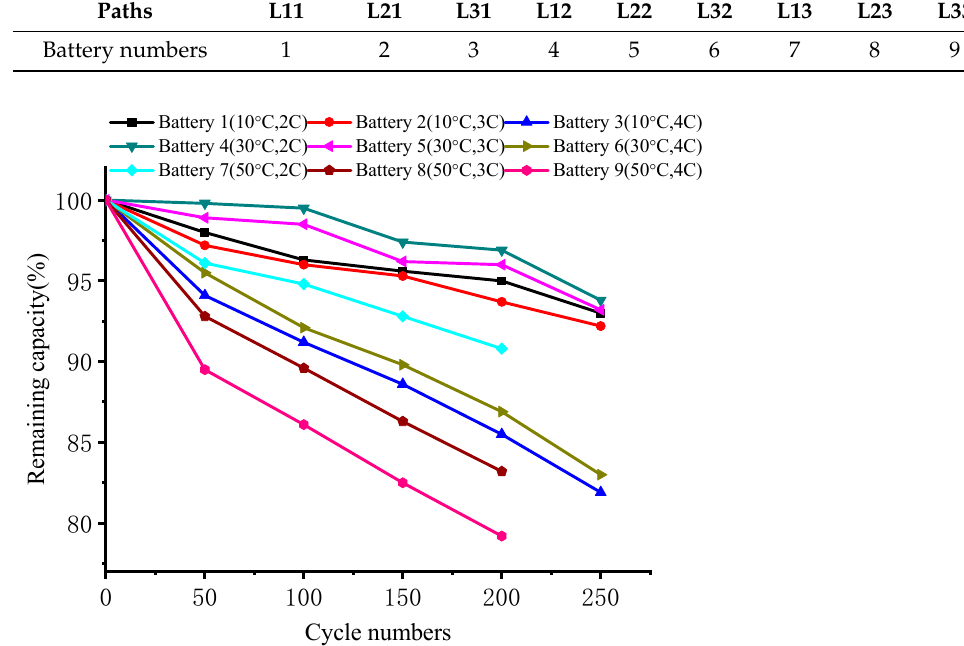
Figure 5. Capacity deterioration of the battery in different aging paths.